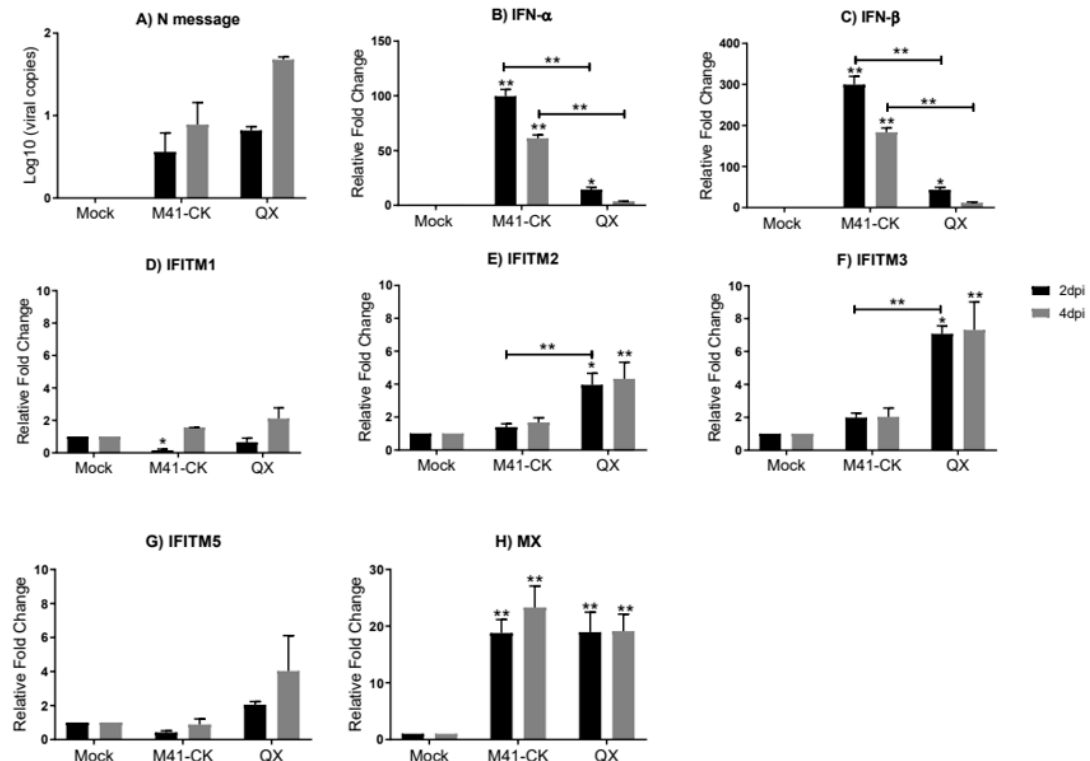
Figure 3. Relative expression of chIFITMs and IFNs in kidney samples from chickens infected with M41-CK and the nephropathogenic QX strain. ( A ) Log 10 of IBV RNA copies in the kidney from chickens infected with pathogenic M41-CK or nephropathogenic QX, or mock infected, measured at 2 and 4 dpi. Relative expression of ( B ) IFN- α , ( C ) IFN- β and ( D – G ) chIFITM1 , 2 , 3 and 5 and ( H ) Mx measured by qRT-PCR in kidney samples collected at 2 and 4 dpi from chickens experimentally challenged with M41-CK and QX IBV, or mock infected. Relative fold change was calculated using the ∆∆ CT equation, relative to mock and normalized to two reference genes, RPLPO and RPL13 . All graph values are the mean of three biological replicates with error bars as standard deviation. * indicates p < 0.05, ** indicates p < 0.01. ANOVA data were corrected for multiple comparisons using the Bonferroni adjustment method